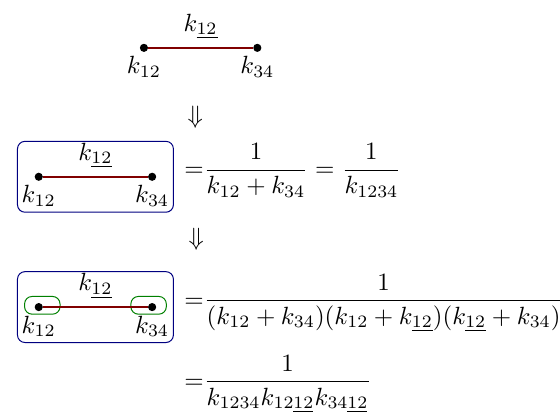
Figure 3 . Algorithm to compute the amplitudes of straight